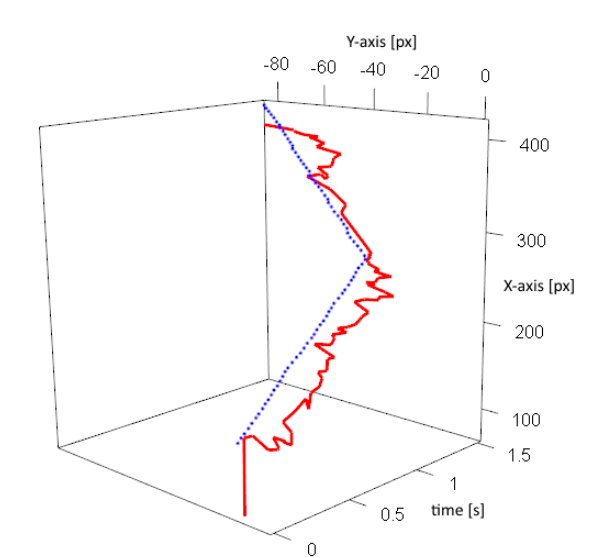
Figure 3 . Exemplary stimulus movement (blue, dotted) and gaze path (red) over